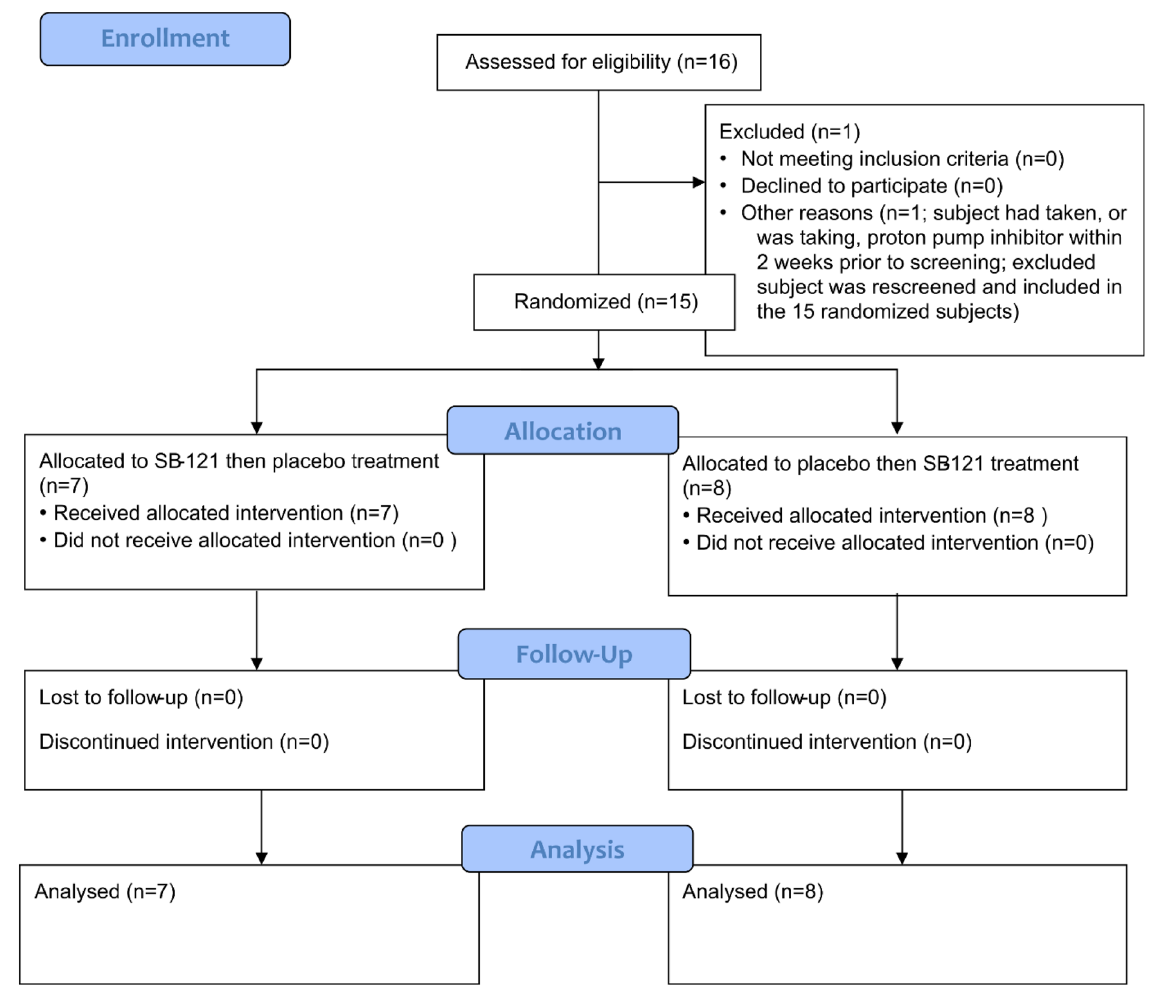
Figure 1. CONSORT diagram. The first participant was enrolled 02 AUG 2021. The last study visit occurred on 03 MAR